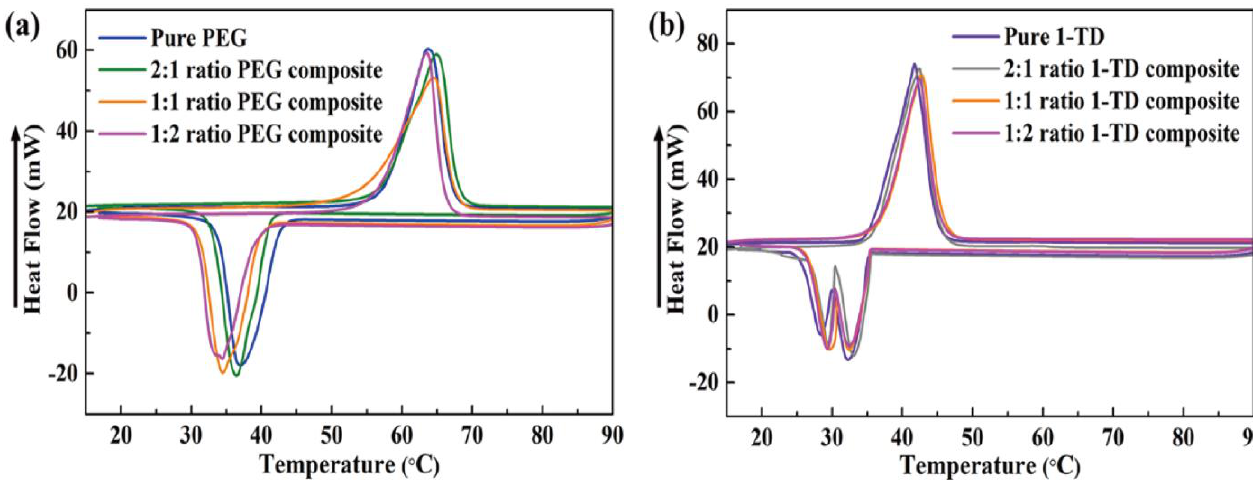
Figure 7. DSC curves of ( a ) pure PEG and PEG composites and ( b ) pure 1-TD and 1-TD composites.